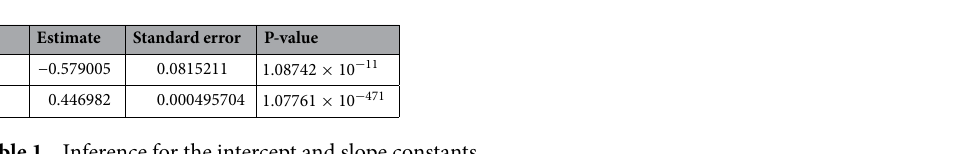
Table 1. Inference for the intercept and slope